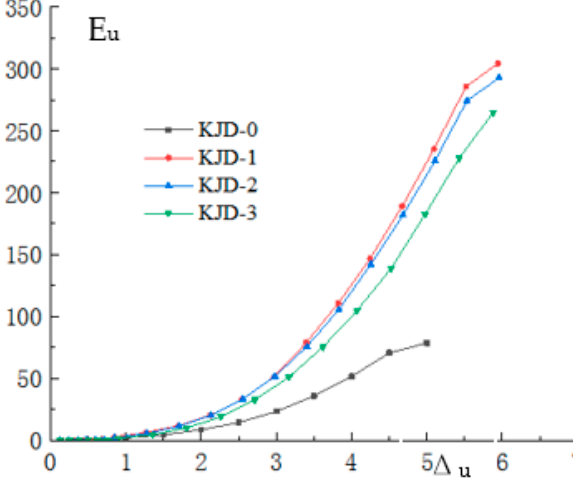
Figure 15. Cumulative energy dissipation curves.